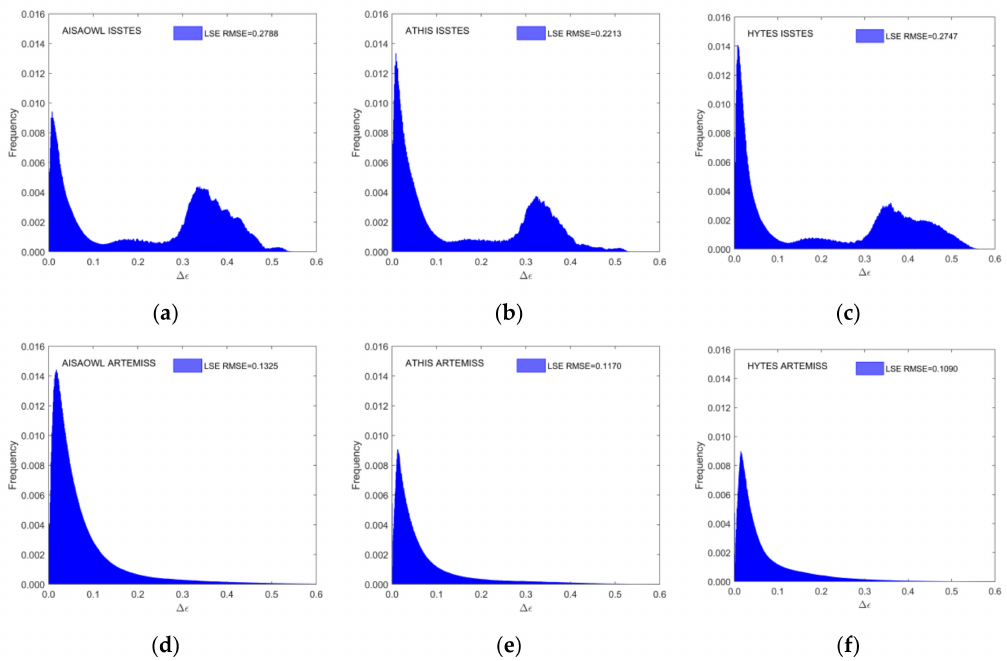
Figure 7. The overall LSE error histogram. The X axis is the LSE error, the right Y axis is the frequency distribution of all retrieval LSE errors and scales the red histogram with RMSE, and the left Y axis is the frequency distribution of the corresponding retrieval LSE errors excluding LST errors of ± 20K and scales the blue histogram in order to highlight the frequency distribution of the LSE error near 0. ( a – c ) LSE error histograms of AISAOWL (100 nm), ATHIS (50 nm) and HYTES (35 nm) inversed by ISSTES respectively; ( d – f ) LSE error histograms of AISAOWL (100 nm), ATHIS (50nm) and HYTES (35 nm) inversed by ARTEMISS